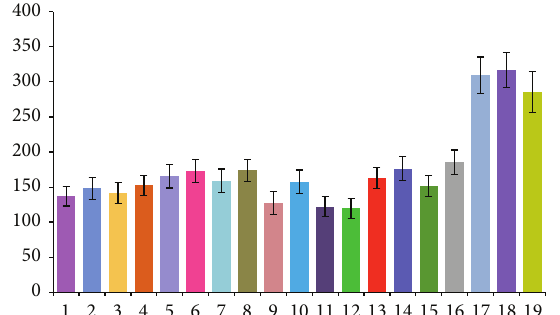
Figure 2: The total content of 41 compounds in different sam- ples. Samples 1–19 are collected from Yingkou, Liaoning; Dalian (Dachangshan Island), Liaoning; Dalian (Clam Island), Liaoning; Yantai,Shandong;Weihai,Shandong;Qingdao,Shandong;Lianyun- gang (Lian Island), Jiangsu; Lianyungan (Qinshan Island), Jiangsu; Wenzhou (Nanfu Island), Zhejiang; Wenzhou, Zhejiang; Ningbo (Meishan Island), Zhejiang; Ningbo (Yushan Island), Zhejiang; Fuzhou (Langqi Island), Fujian; Fuzhou (Dongjia Island), Fujian; Xiamen(DadengIsland),Fujian;Xiamen(GulangyuIsland),Fujian; Sanya (Sanya Bay), Hainan; Sanya (Wuzhizhou Island), Hainan and Haikou, Hainan.